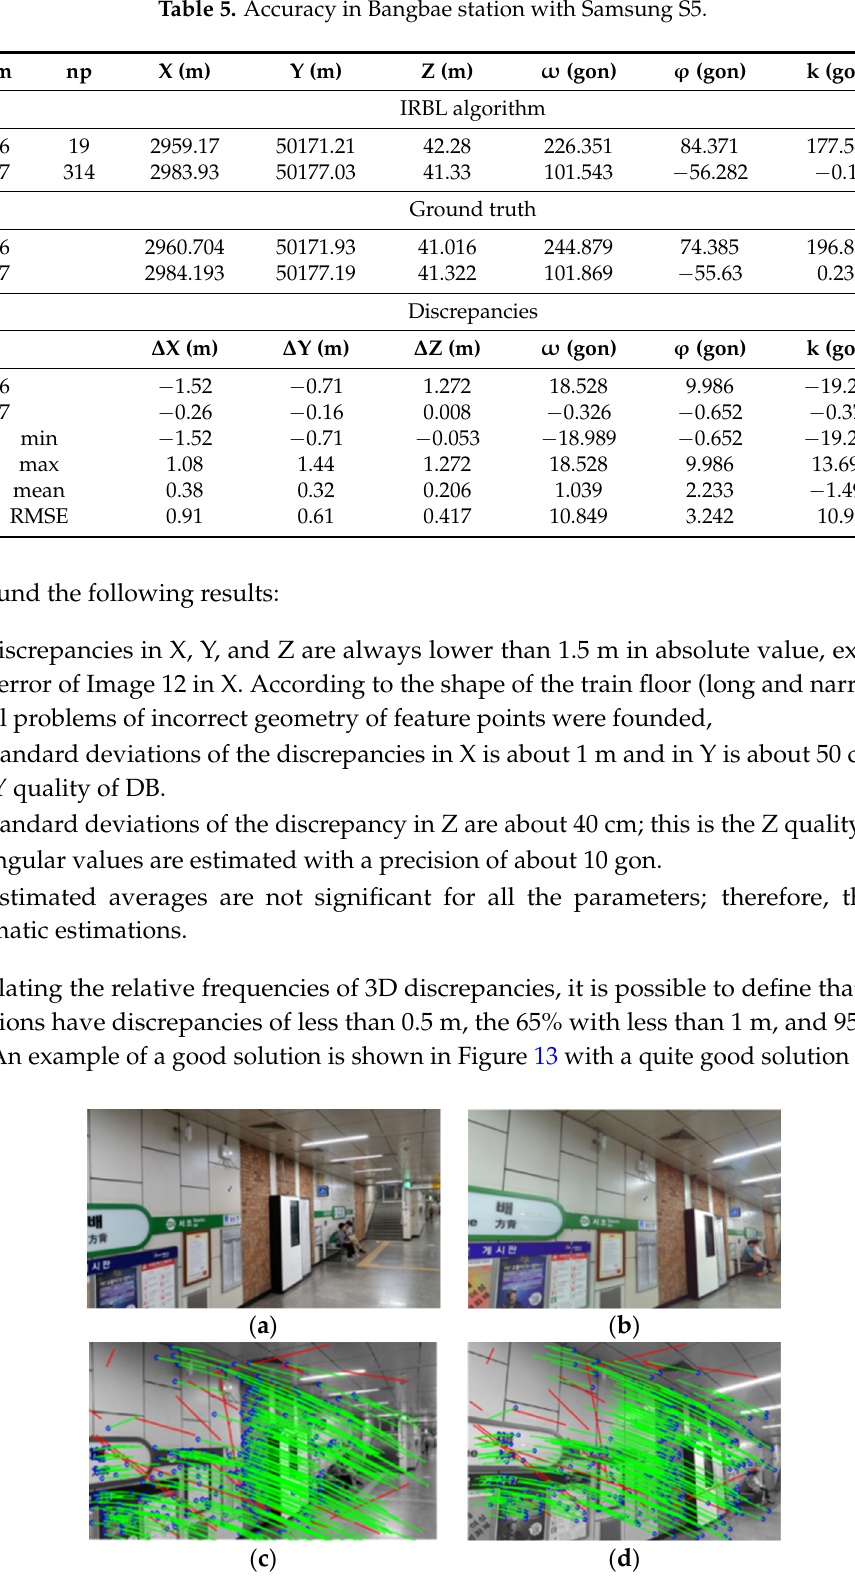
Figure 13. A good solution for Bangbae station, Image 17: ( a ) query image; ( b ) reference image from DB; ( c ) query image; and ( d ) reference image with used feature points; the matched points that have been rejected are in red.